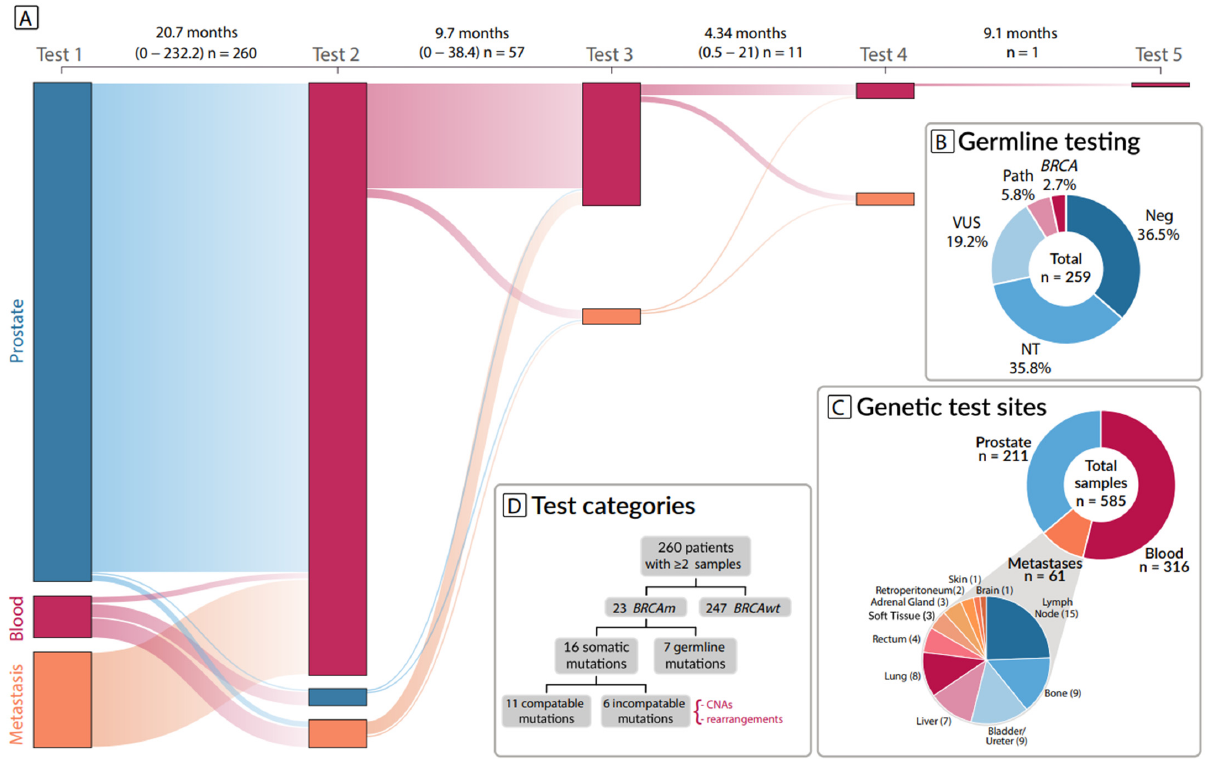
Figure 1. ( A ) Sankey diagram of all samples, the median and range for the time interval between each test is shown at the top. ( B ) Germline testing results, germline BRCA1/2 mutation ( BRCA ), not tested (NT), variant of uncertain significance (VUS), pathogenic variant (Path), negative result (Neg). ( C ) Sites for the samples with the metastatic samples broken down based on specific location. ( D ) patient selection workflow, copy number alterations (CNAs), BRCA mutations ( BRCAm ), BRCA wild-type ( BRCAwt ).